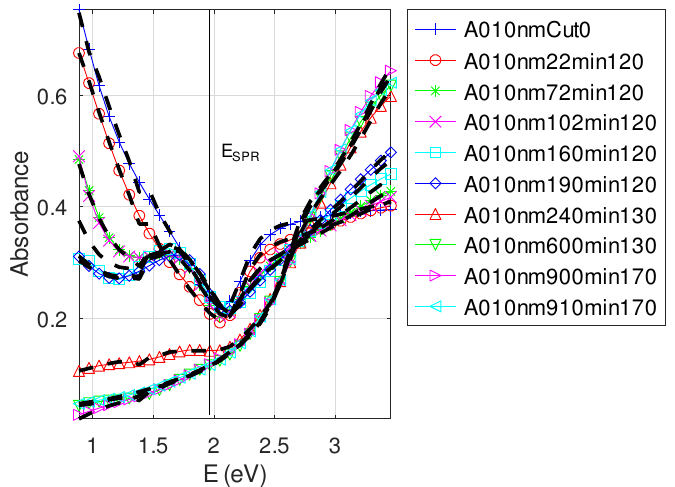
Figure A1. Absorbance as a function of the photon energy: experimental (black dashed) and best calculated solution (color) for each oxidized sample (initial thickness h 0